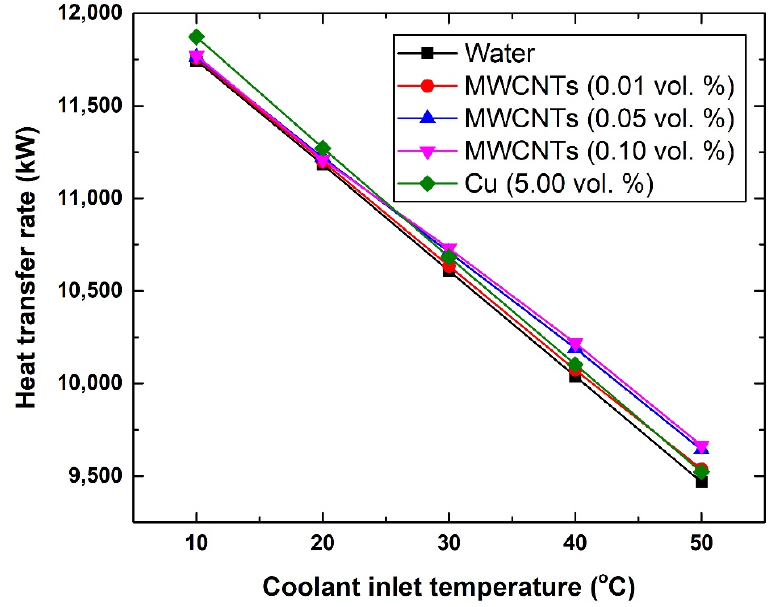
Figure 7. Changes in the heat transfer rate with respect to coolants inlet temperature.